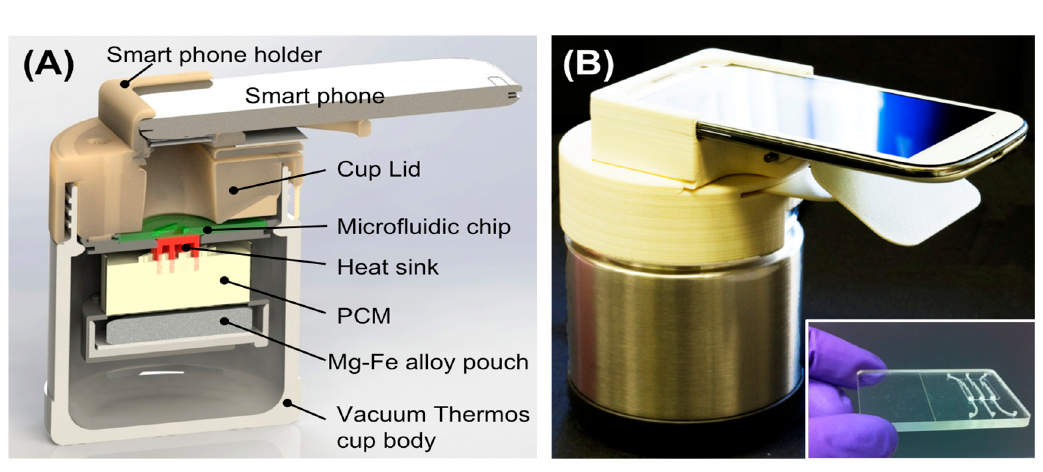
Figure 10. Smart Cup: The Smart cup is a customized Thermos ® bottle that provides the inserted single-use chip with constant temperature heating. The Smart Cup has a built in mount for positioning a Smartphone CCD camera to monitor the reaction progress. Heating is due to an exothermic reaction of Mg-Fe powder initiated by addition of water. A phase-change material (PCM) maintains the chip at a constant ~65 °C temperature for about 60 min. ( A ) Cross-section of Smart Cup showing Mg-Fe alloy pouch that is activated by adding water to initiate heating, PCM, heat sink and slot holding microfluidic chip. Smartphone is held for optimal focus of Smartphone CCD camera on chip amplification chamber to measure fluorescence; ( B ) field unit and companion chip (inset). The smart cup can be optionally made of Styrofoam, making the entire system disposable. From [144].